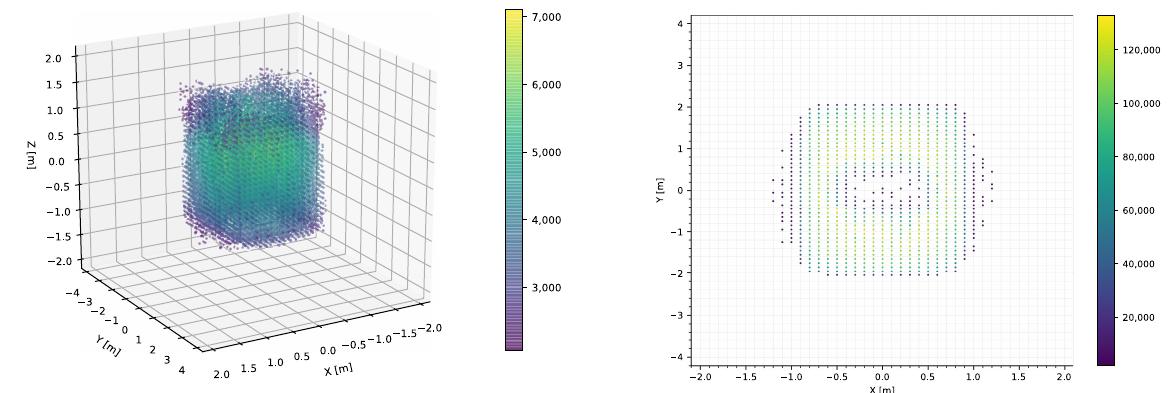
Figure 14. The 3D voxel map of the lead block in the water basin ( left ) and its 2D projection ( right ) reconstructed with the parameter set optimized for water as shown in Table 4. The color of the voxel point represents the combined voxel score s comb .